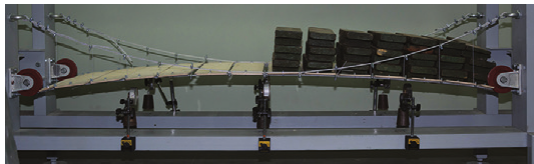
Fig. 6. Non-symmetrical load applied to the physical model of prestressed suspension